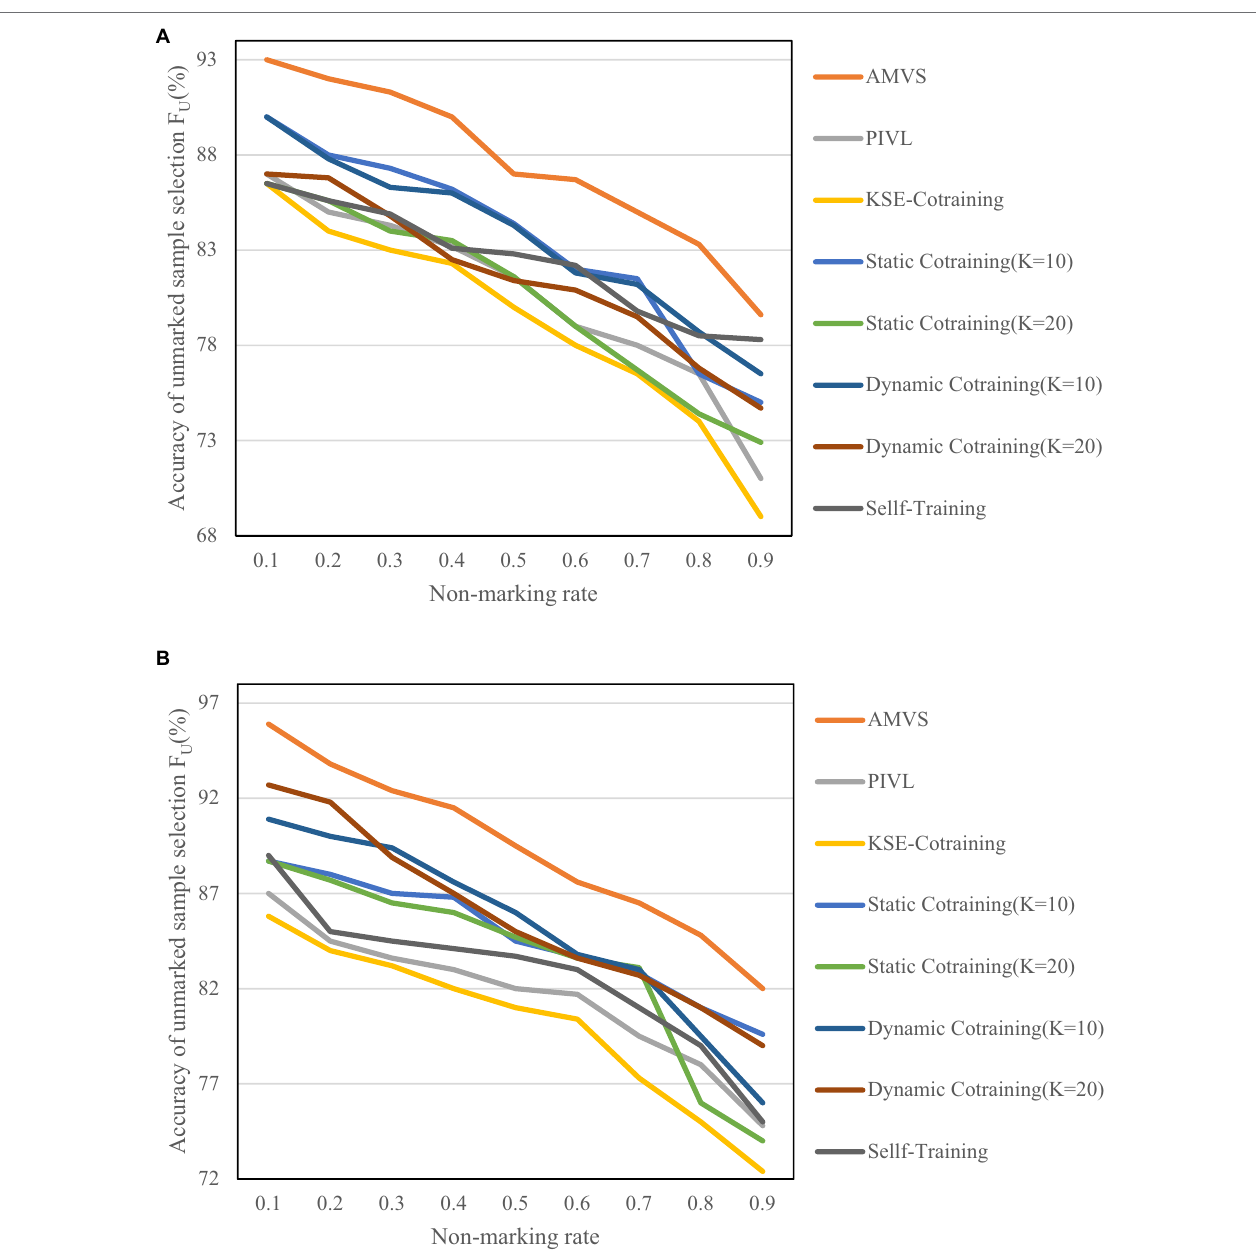
FIGURE 8 | Variation of unmarked sample selection accuracy F U at different unmarked rates. (A) Variation of F U when the base classifier is MNB. (B) Variation of F U when the base classifier is